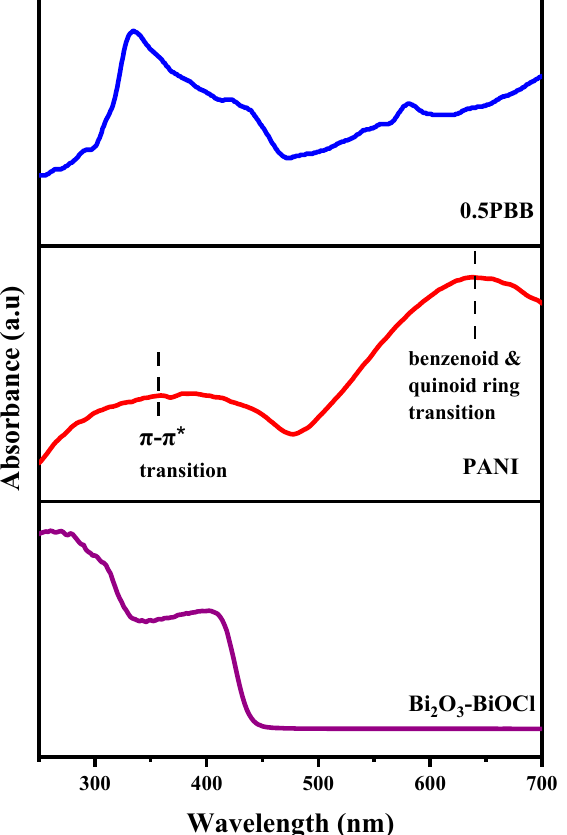
Figure 6. UV–Visible spectra of Bi 2 O 3 -BiOCl, PANI, and 0.5PBB.